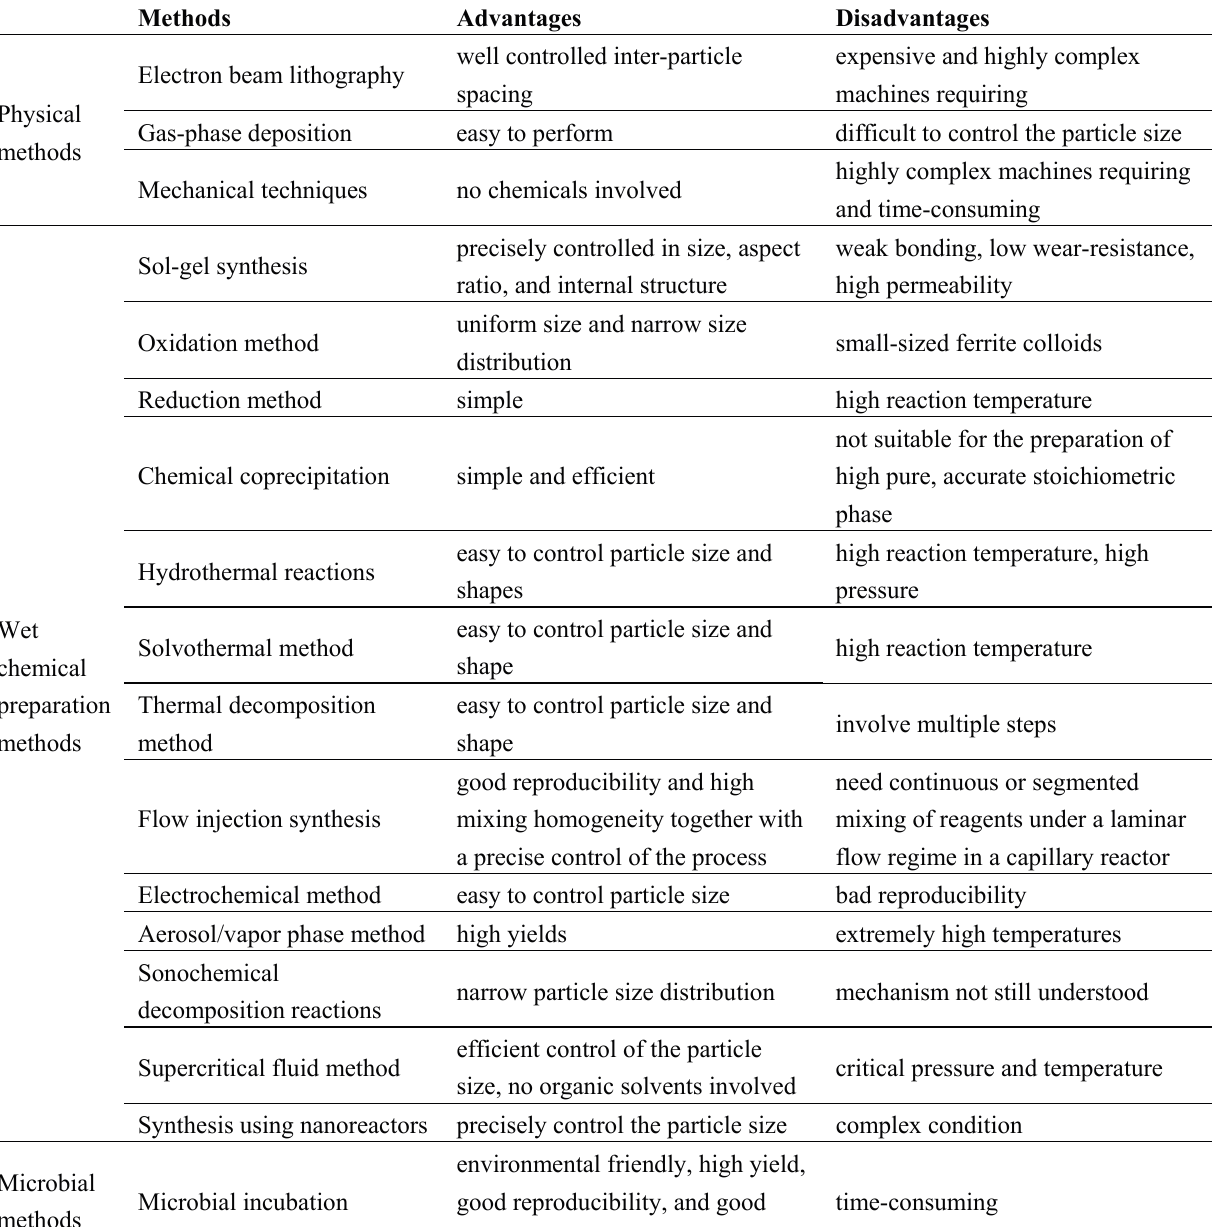
Table 1. Comparation between methods for synthesis of magnetic nanoparticles